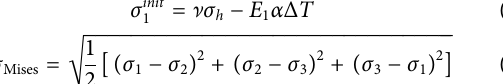
Figure 5 . The displacement of points A and D at the in fi nite far end of the horizontal pipeline is 0. The displacement at points B and C in the horizontal direction is converted into the slope direction. It was assumed that the displacement of the slope u total